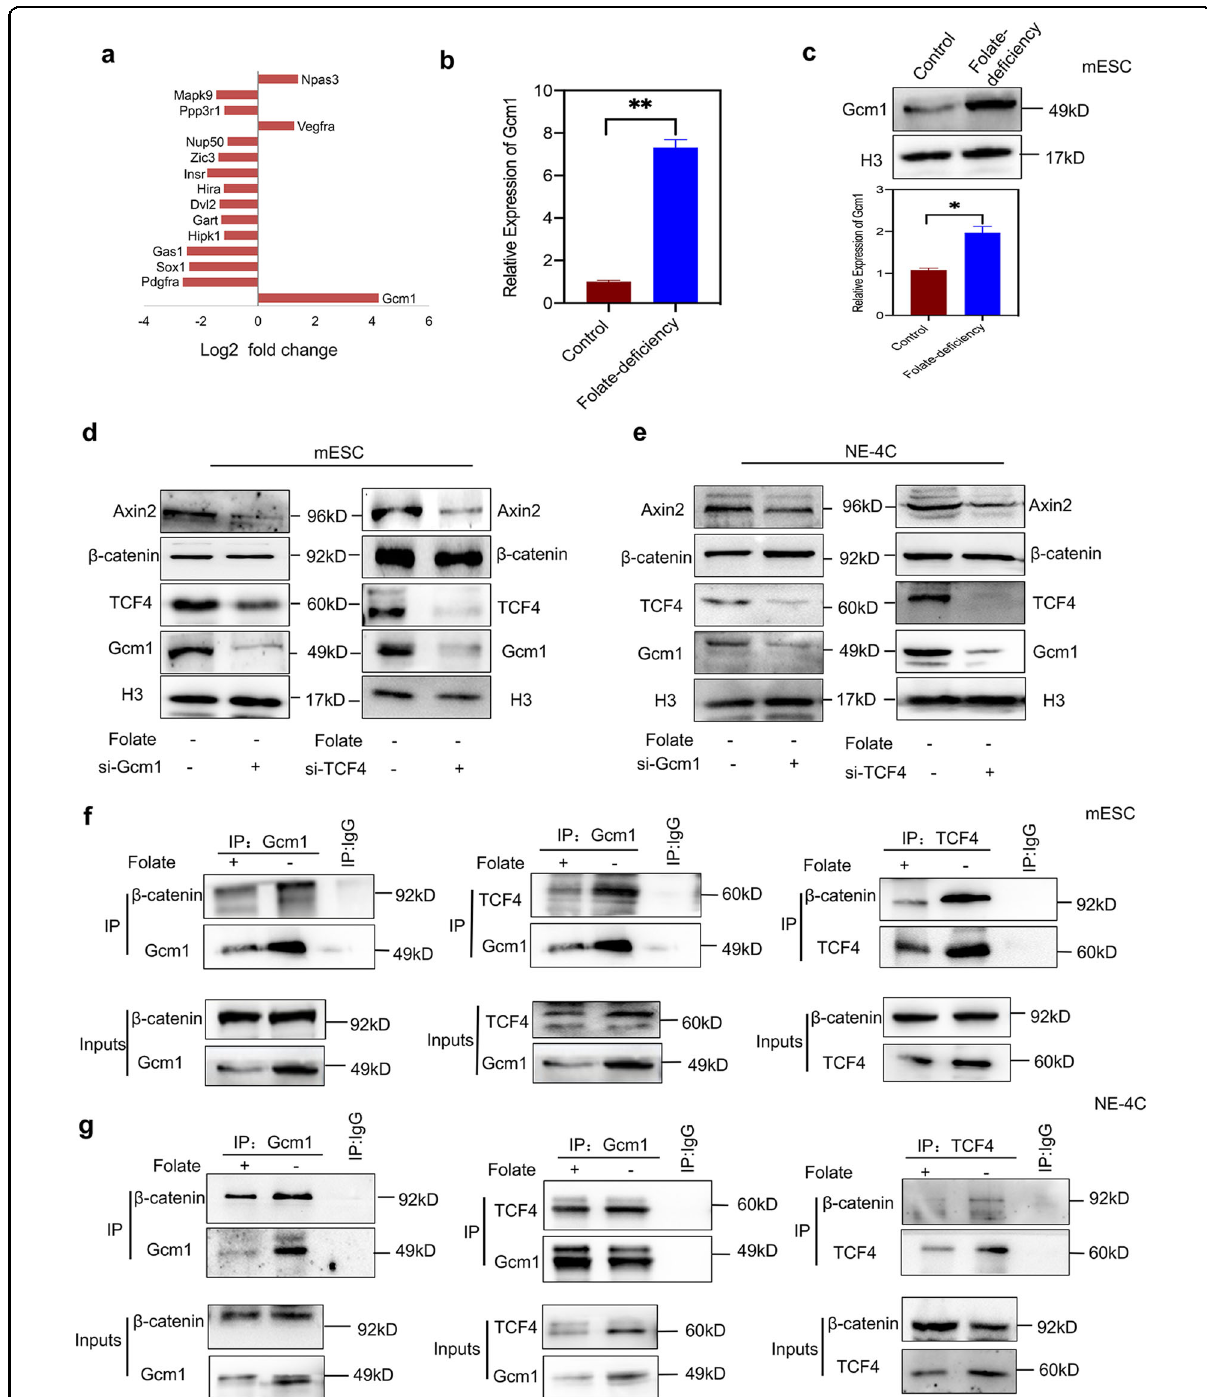
Fig. 2 (See legend on next